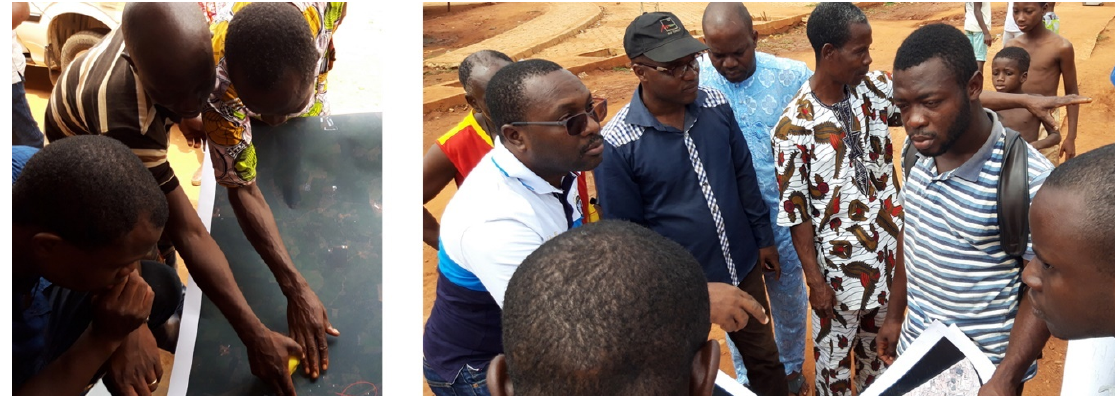
Figure 6. Field tests using aerial photography to identify parcels.